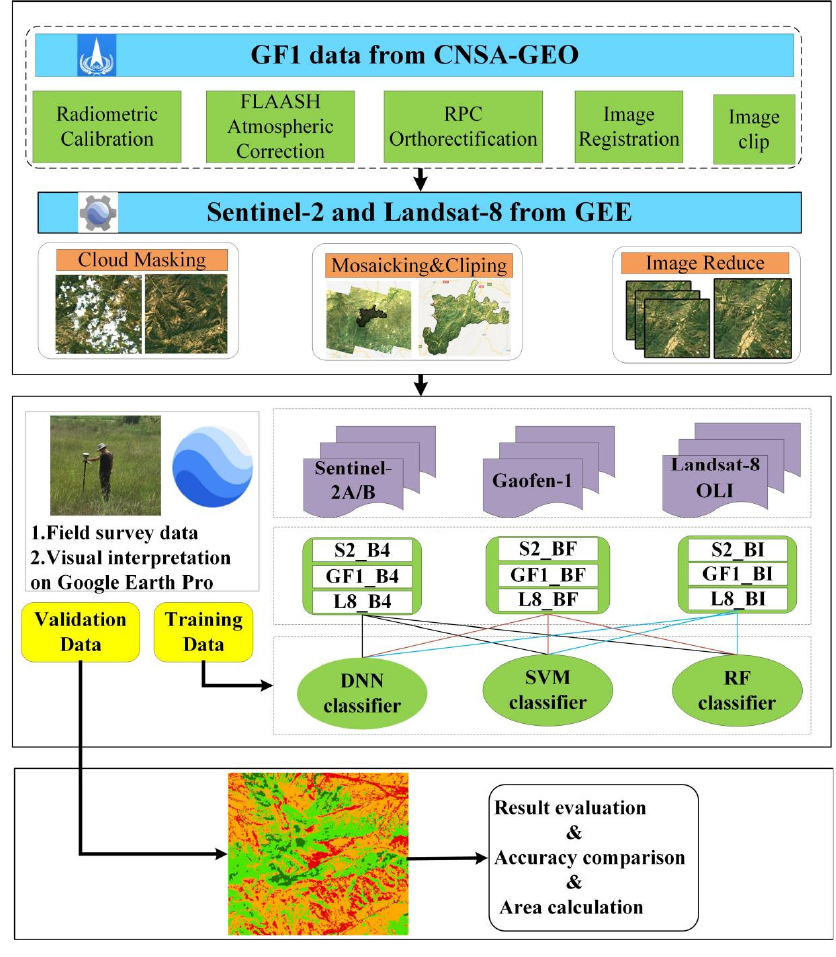
Figure 2. Work flow of this study.